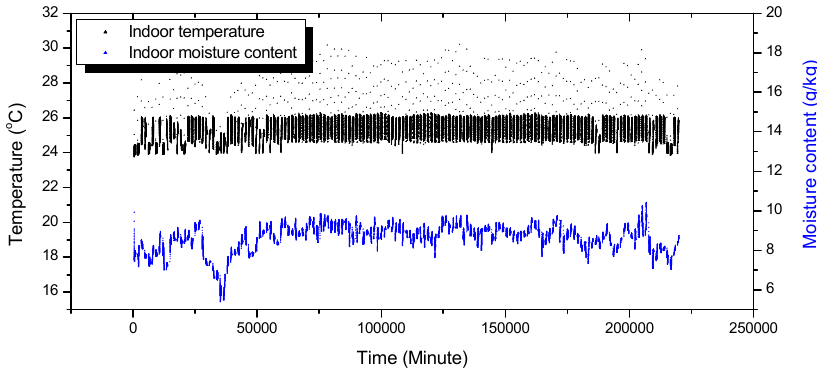
Figure 1. Indoor temperature and humidity variation in cooling season.